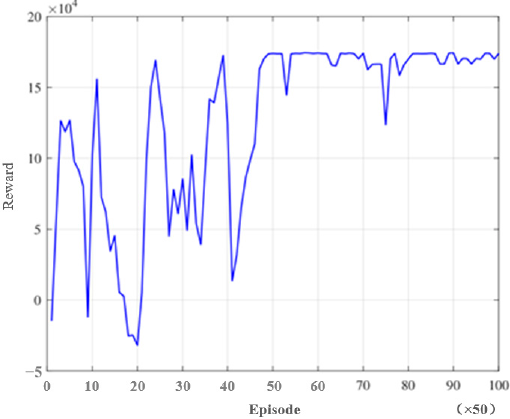
Figure 10. Episodic reward during the training process of the DRL.